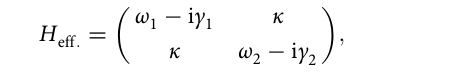
Bose – Einstein statistics describing the mean number of photons that are emitted from reservoir α with frequency ω . Finally, T α is the temperature of the α - th reservoir.